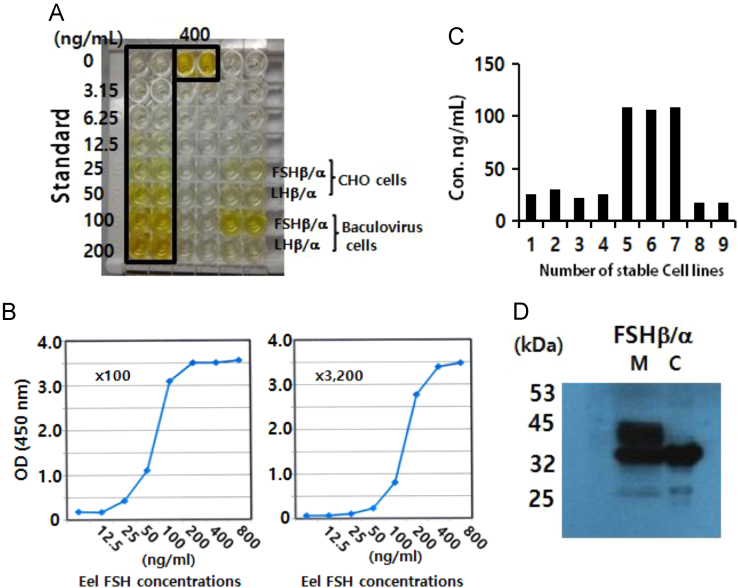
Quantification of rec-FSHβ/α and LHβ/α amounts by using sandwich-ELISA system. (A) Proteins (rec-FSHβ/α and LHβ/α) produced from CHO cells and baculovirus-infected cells were analyzed by performing sandwich ELISA. (B) The HRP-conjugated anti-eel FSH monoclonal antibody eFA-C11, diluted 100–3200 times, was tested; this dilution range of the HRP-labeled antibody efficiently described the standard curve. (C) Quantities of rec-FSHβ/α produced from stable cell lines were also determined. (D) Western blotting performed using eFA-C5 antibody is shown here. The 2nd antibody used was goat anti-mouse (1:3000). The monoclonal antibody detected a single ~34-kDa FSHβ/α band in the medium (M) and cell lysates (C).